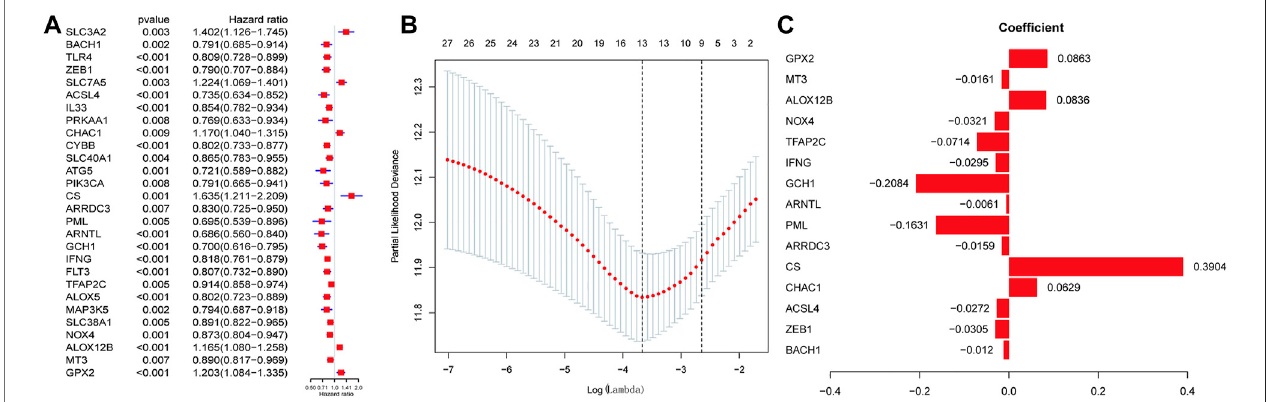
FIGURE2| Discoveringferroptosis-relatedgeneswiththemostsigni fi cantprognosticvalues. (A) UnivariateCoxAnalysisofthecandidateferroptosis-relatedgene set. (B) Cross-validation for tuning parameter selection in the proportional hazards model. (C) Lasso coef fi cient spectrum of ferroptosis-related genes related to prognosis in